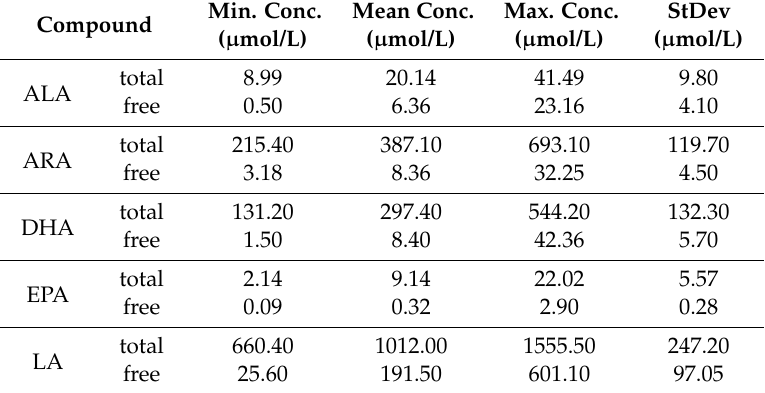
Table 2. Descriptive statistics of quantification results: Minimum, median, and maximum concentrations found, and the standard deviation for each quantified fatty acid (total and free). Min. Compound